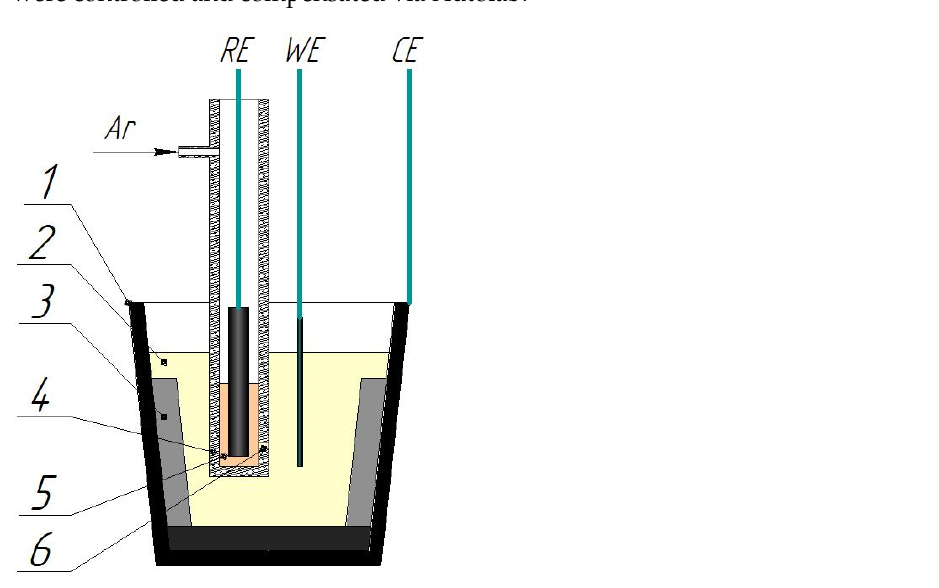
Figure 1. Schematic of the electrochemical cell: 1—glassy carbon reactor crucible; 2—studied elec- trolyte; 3—rhenium rod (counter electrode); 4—BN body of the reference electrode; 5—KF-KBF4-B2O3-KReO4 (6 wt.%) melt; 6—capillary composed of porous BN.